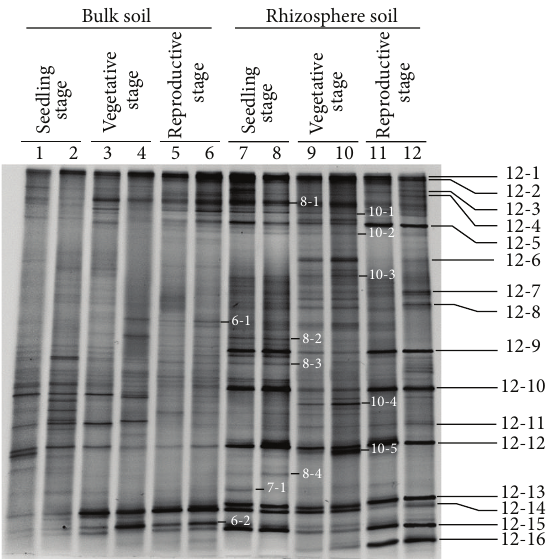
Figure 2: DGGE profiles of 18S rDNA fragments present in DNA extracted from bulk soil (lanes 1–6) and rhizosphere (lanes 7–12) sampled at various developmental stages of growing chrysanthemum plants. Lanes 1, 2, 7, and 8: seedling stage, lanes 3, 4, 9, and 10: vegetative stage, and lanes 5, 6, 11, and 12: reproductive stage. Fragments excised for sequencing are indicated by numbers (Table 2).